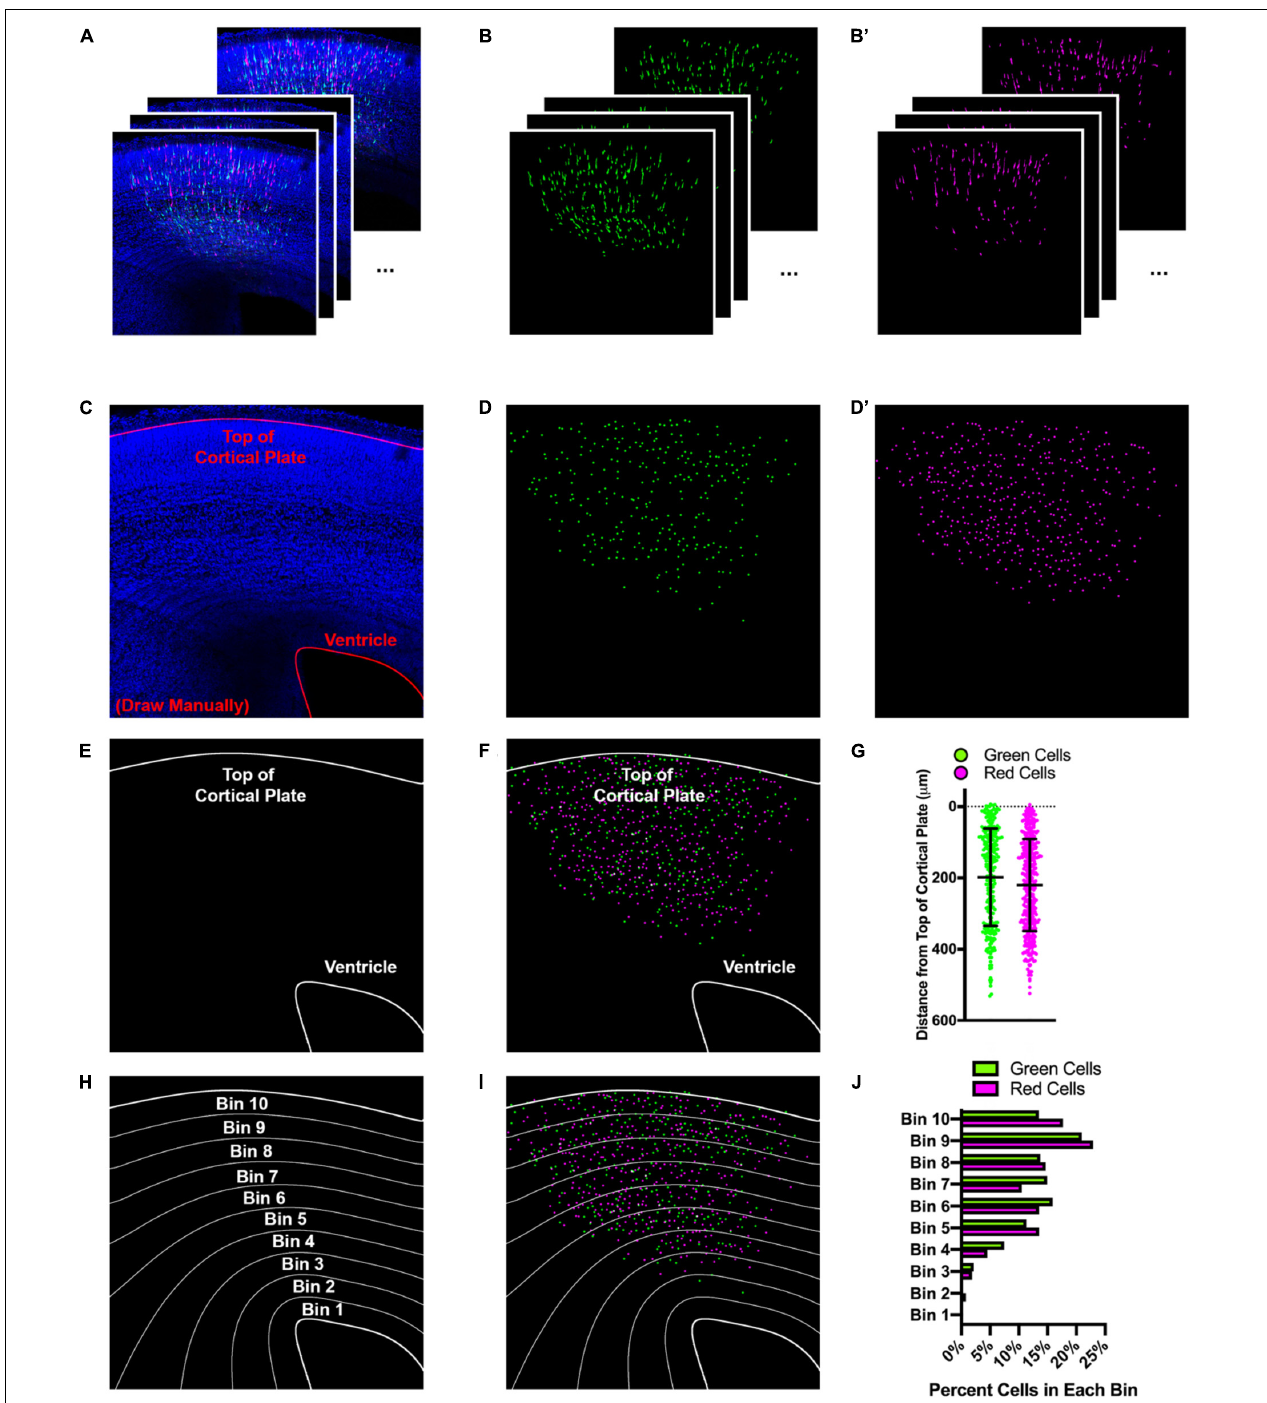
FIGURE 2 | Automated tracking of cellular location with TRON program. Example of data analysis using the TRON program. (A) Example input. 12, three-color confocal slices from a 100 µ m coronal brain slice from an E14.5 + 3 embryo after IUE. (B) Green and (B’) red colors, processed independently and automatically via: unsharp mask, gaussian blur, conversion to 8-bit, automatic threshold, erode, watershed. (C) Manual drawing of regions of interest (ROIs—red lines at top of cortical plate and ventricle). This is the only manual step in the process. (D,D’) Output of modified 3D Object Counter plugin from Fiji. Center of mass of each cell is identified and mapped; X , Y location and brightness of original is obtained and recorded. (E) Tracings of the top of the cortical plate and ventricle (ROIs). (F) Location of each cell mapped onto the ROIs. Distance from the center of each cell to the nearest point on each ROI is measured and recorded. (G) Graphical representation of distance each cell is from top of the cortical plate. Cells located above the top of the cortical plate are treated as having a “negative” distance. Lines indicate mean and SD. (H) Distance between ROIs can be split into bins, calculated to reflect the ROI to which they are closest. (I) Location of each cell mapped onto the bins. (J) Graphical representation of the data split into 10 equal-sized bins, each bar shows percentage of cells of that color in the respective bin.